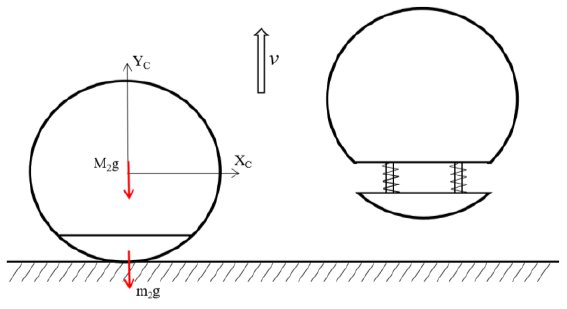
Figure 14. Jumping motion diagram.